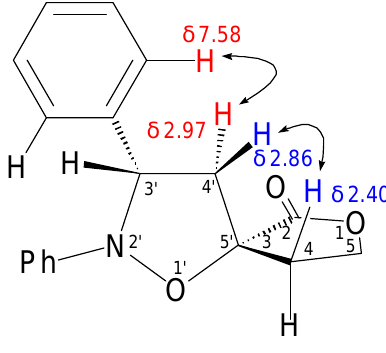
Figure 3. NOESY correlations for the minor isomer 3b .